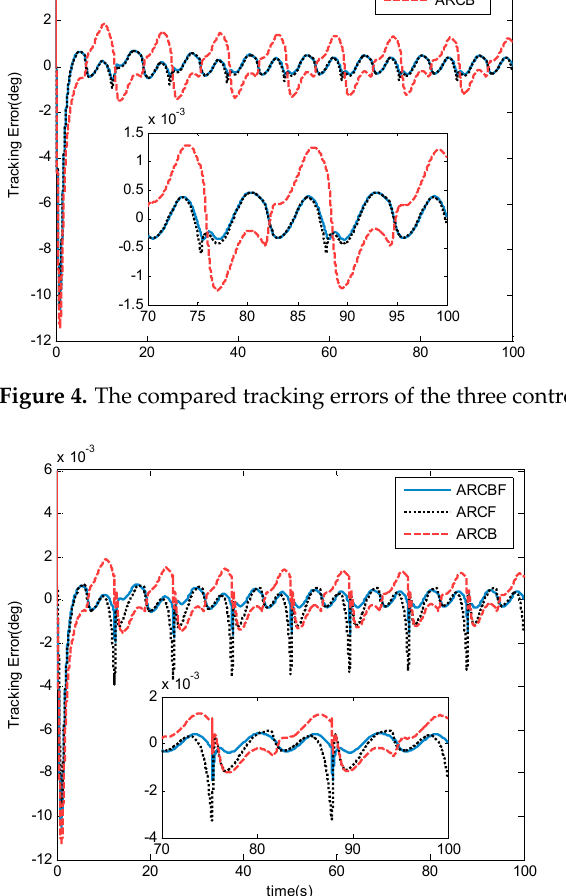
Figure 5. The compared tracking errors of the three controllers as ε = 1 × 10 − 5 .